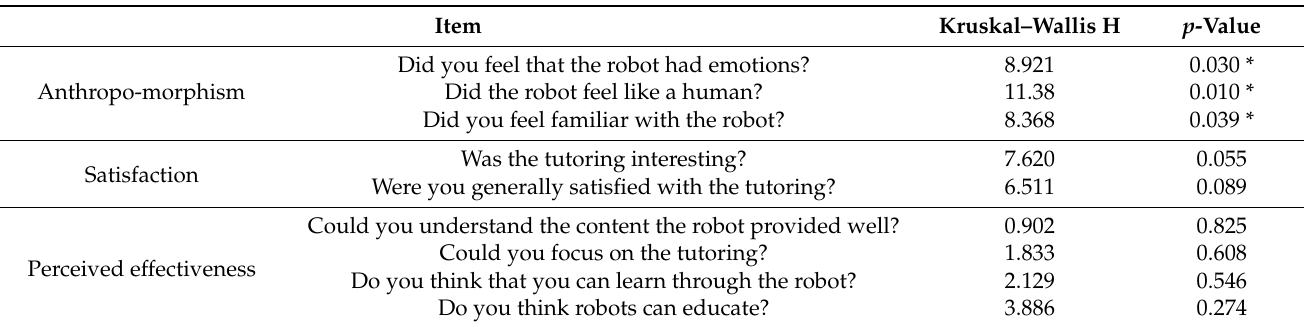
Table 5. The results of the Kruskal–Wallis test on the subjective evaluation according to interac- tion type.